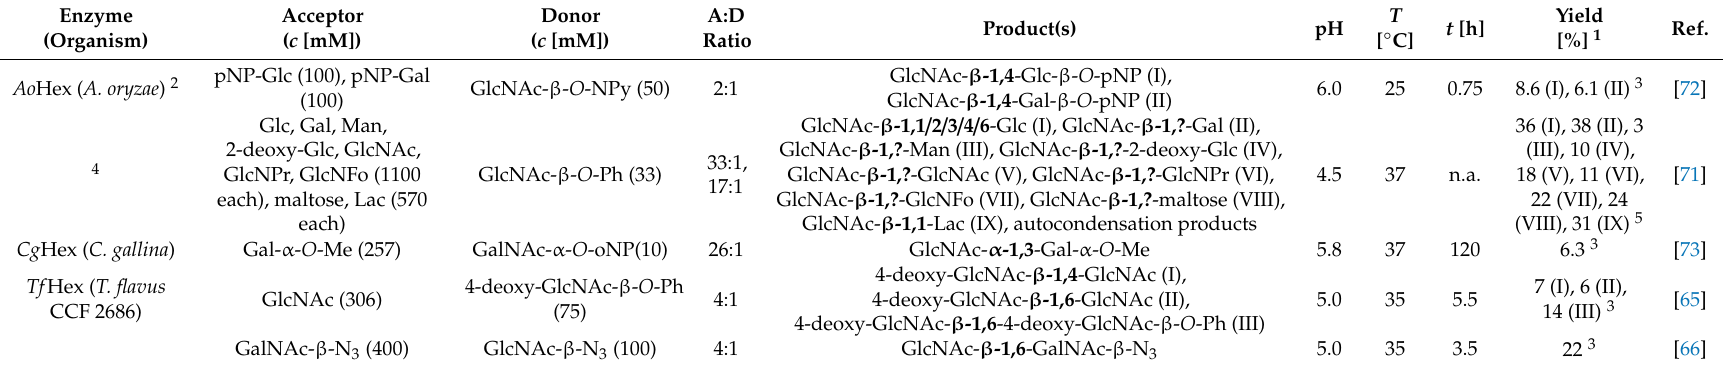
Table 7. Trans-glycosylation reactions catalyzed by GH20 β - N -acetylhexosaminidases using other activated carbohydrate donor substrates. New bonds are highlighted in